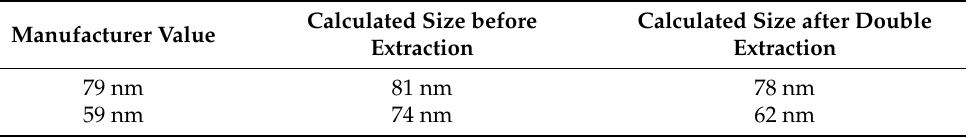
Table 3. Particle size of the AgNPs determined by SP-ICPMS in a mixture of Ag + :AgNPs 5:1 before and after a double extraction with Dowex 50W-X8 cation-exchange